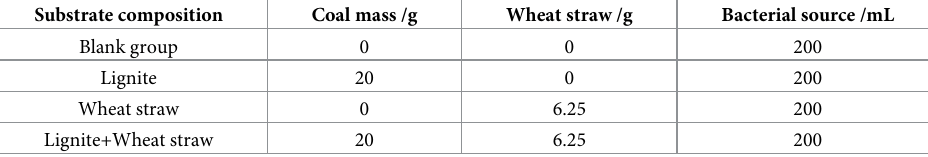
Table 2. Fermentation substrate ratio of contrast experiment for biomethane